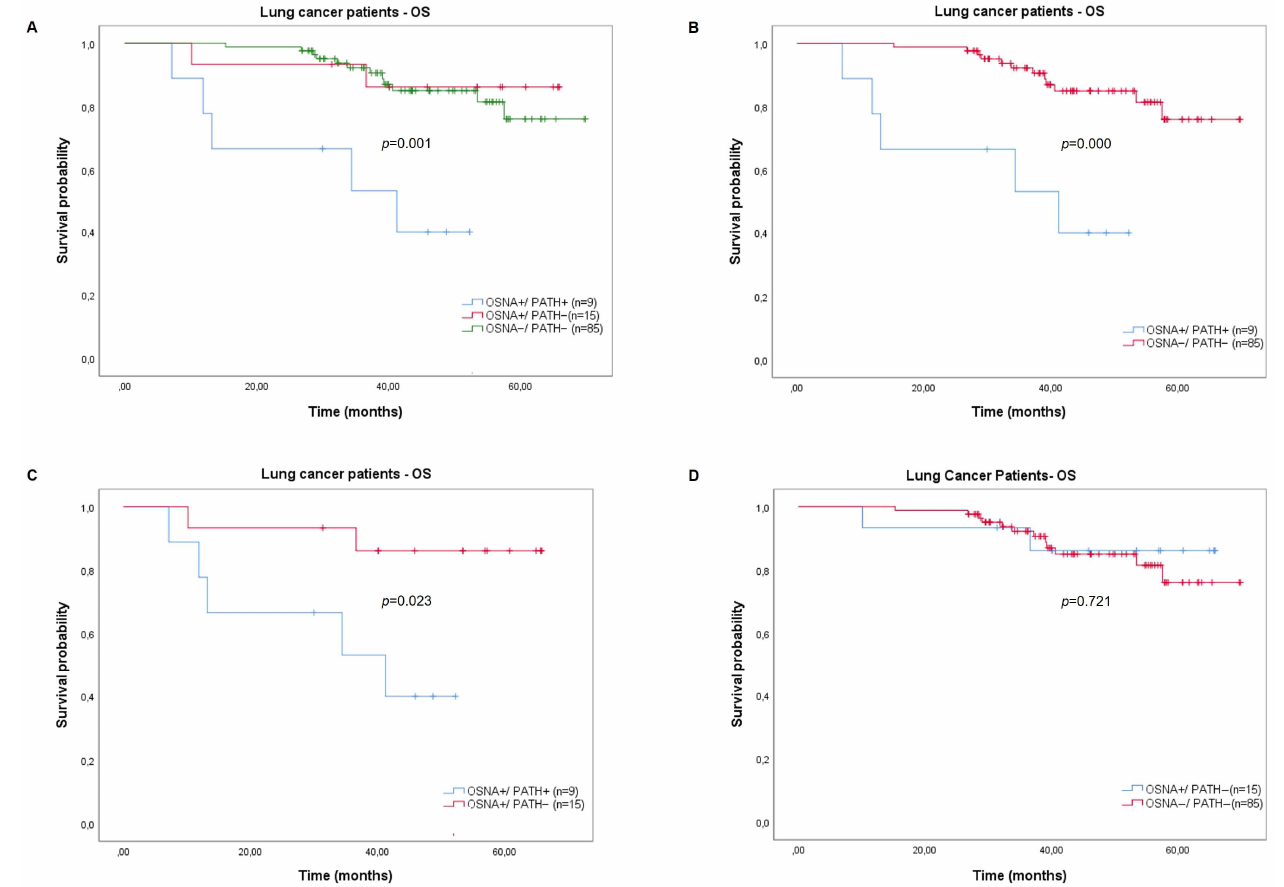
Figure 3. Kaplan-Meier curves comparing OS distribution according to three patient pro- files OSNA+/PATH+, OSNA+/PATH − and OSNA − /PATH − ( A ). OS of lung cancer patient OSNA+/PATH+ vs. OSNA − /PATH − ( B ); OSNA+/PATH+ vs. OSNA+/PATH − ( C ); and OSNA+/PATH − vs. OSNA − /PATH − ( D